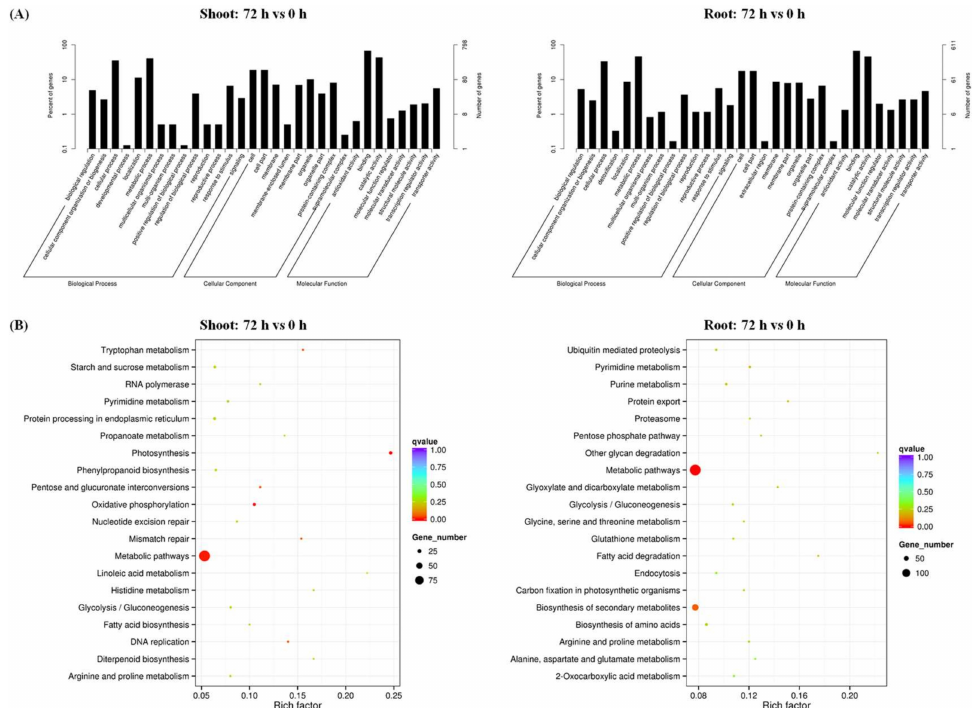
Figure 5. Functional enrichment analysis of di ff erentially methylated genes (DMGs) between N su ffi ciency and N limitation in rapeseed plants. ( A ) Gene Ontology and ( B ) Kyoto Encyclopedia of Genes and Genomes (KEGG) pathway analysis of the DMGs in the shoots and roots of rapeseed plants under N limitation. The times of 0 h and 72 h refer to the time after treatment of N